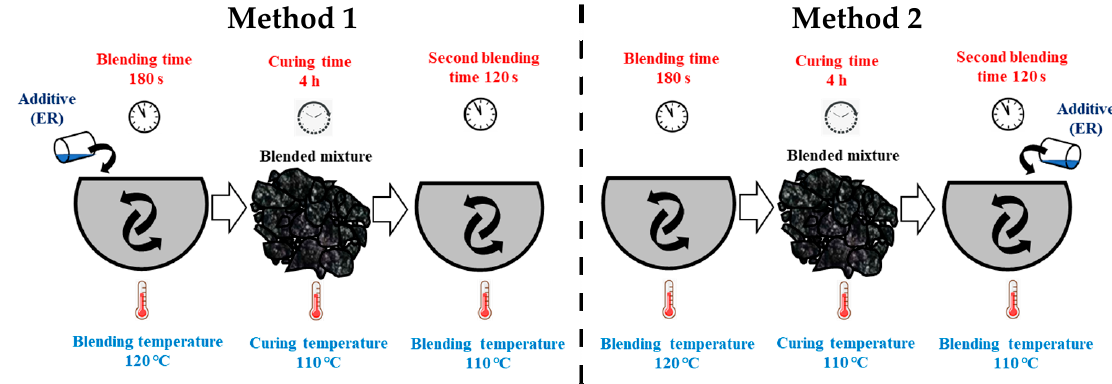
Figure 4. Different ER mixing methods.